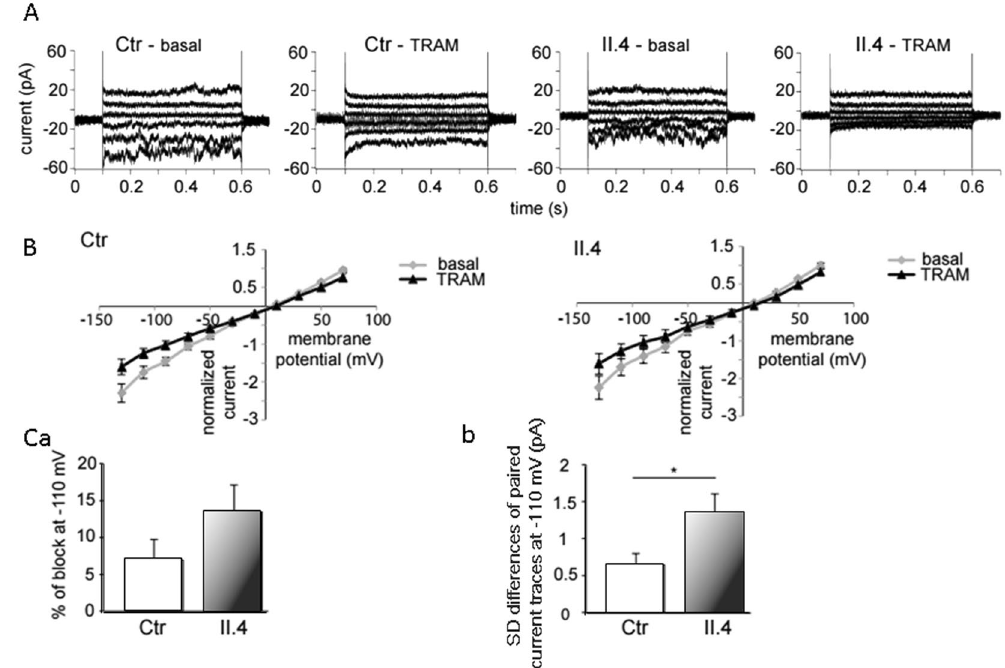
Figure 3. Whole-cell recordings of KCNN4 (Gardos channel) currents in RBCs from healthy donors and patient II.4. Currents were elicited by voltage steps from − 130 mV to 70 mV for 500 ms in 20 mV increments at V h = − 30 mV and recorded in the absence and after application of 1 µ M TRAM-34, a specific Gardos channel blocker. ( A ) Raw current traces from healthy and mutated RBCs in the absence (basal) and in the presence of 1 µ M TRAM-34 as indicated above the recordings. For clarity, in all the panels, not all the traces, but every second one, starting with − 130 mV, are being shown. ( B ) Corresponding I/V-curves in the absence of 1 µ M TRAM-34, basal (grey diamonds) and in the presence of 1 µ M TRAM-34 (black triangles) for healthy (Ctr) and mutated (II.4) RBCs. Data are expressed as mean current ± SEMs. ( C ) Differences in Gardos currents between healthy (n = 27 cells) and mutated RBCs (n = 23 cells) at − 110 mV. ( Ca ) compares the percent of block (by 1 µ M TRAM-34) of mean currents in healthy and mutated RBCs. Due to the small number and small single channel conductivity of Gardos channels in RBCs an additional assessment of Gardos currents is given by analysis